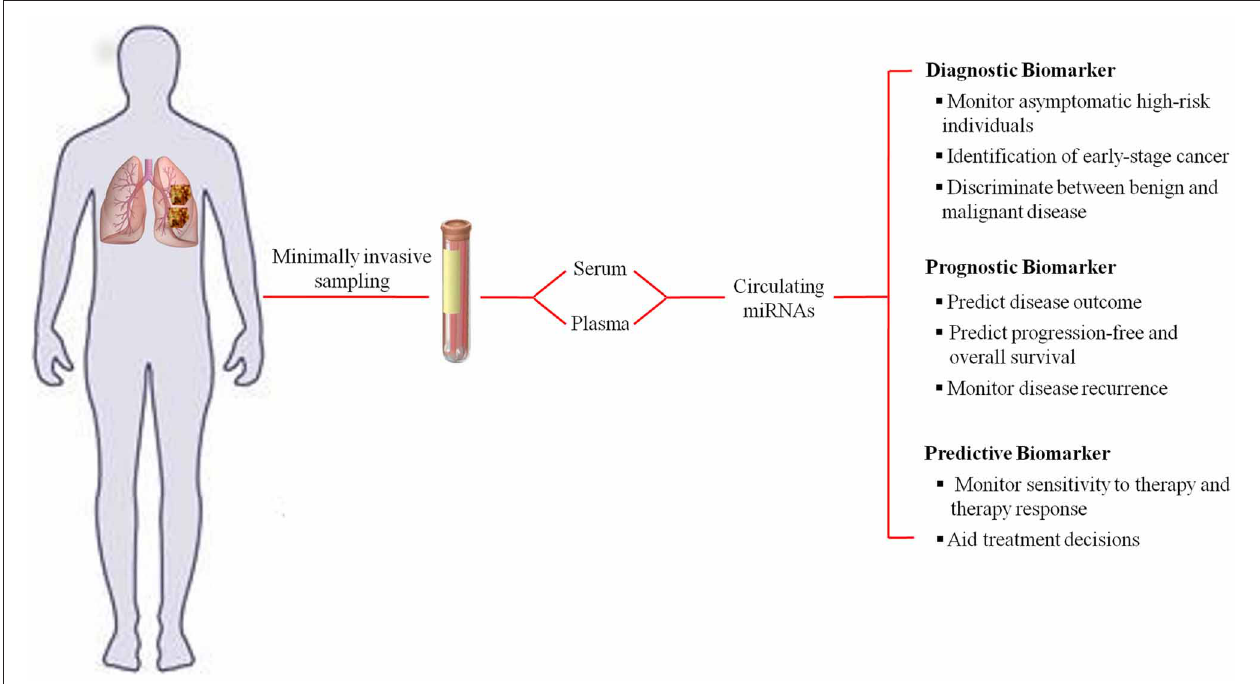
FIGURE 1 | Representation of the diagnostic, prognostic, and predictive uses of circulating miRNAs as a biomarker using lung cancer as an example.